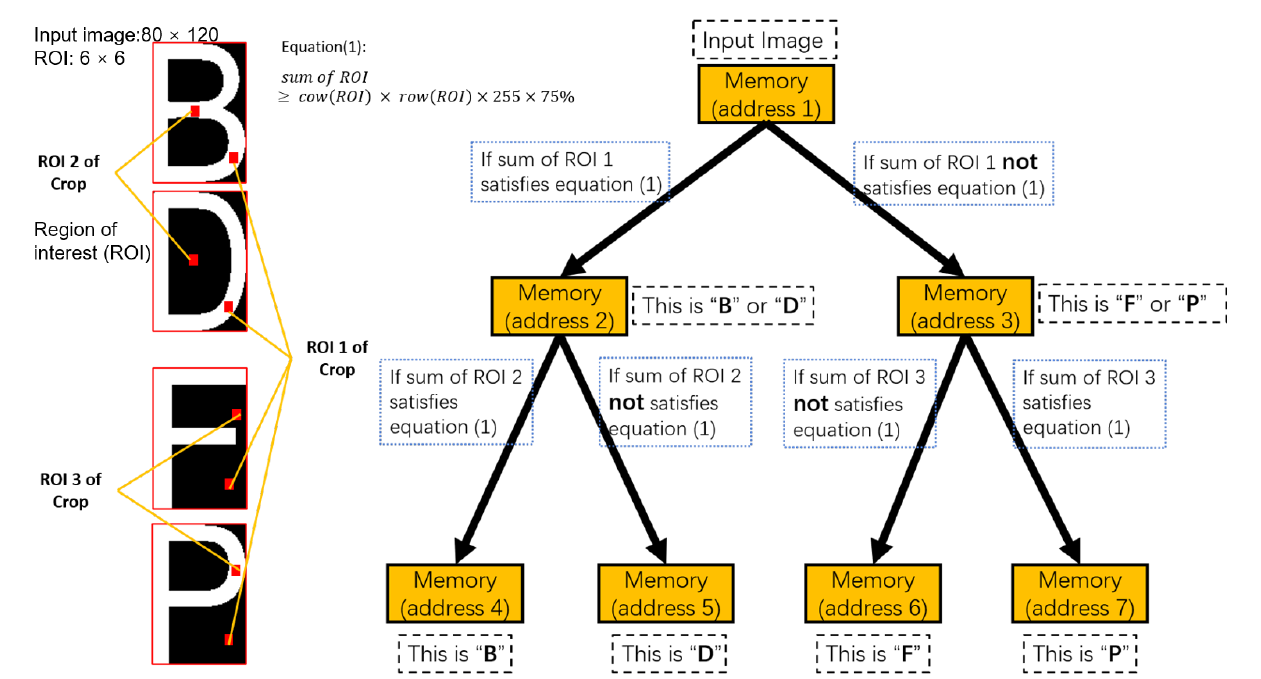
Figure 6. Description of the core principle of the Memory-Tree optimization algorithm in the character recognition (CR) stage with the example of distinguishing “B”, “D”, “F” and “P”.